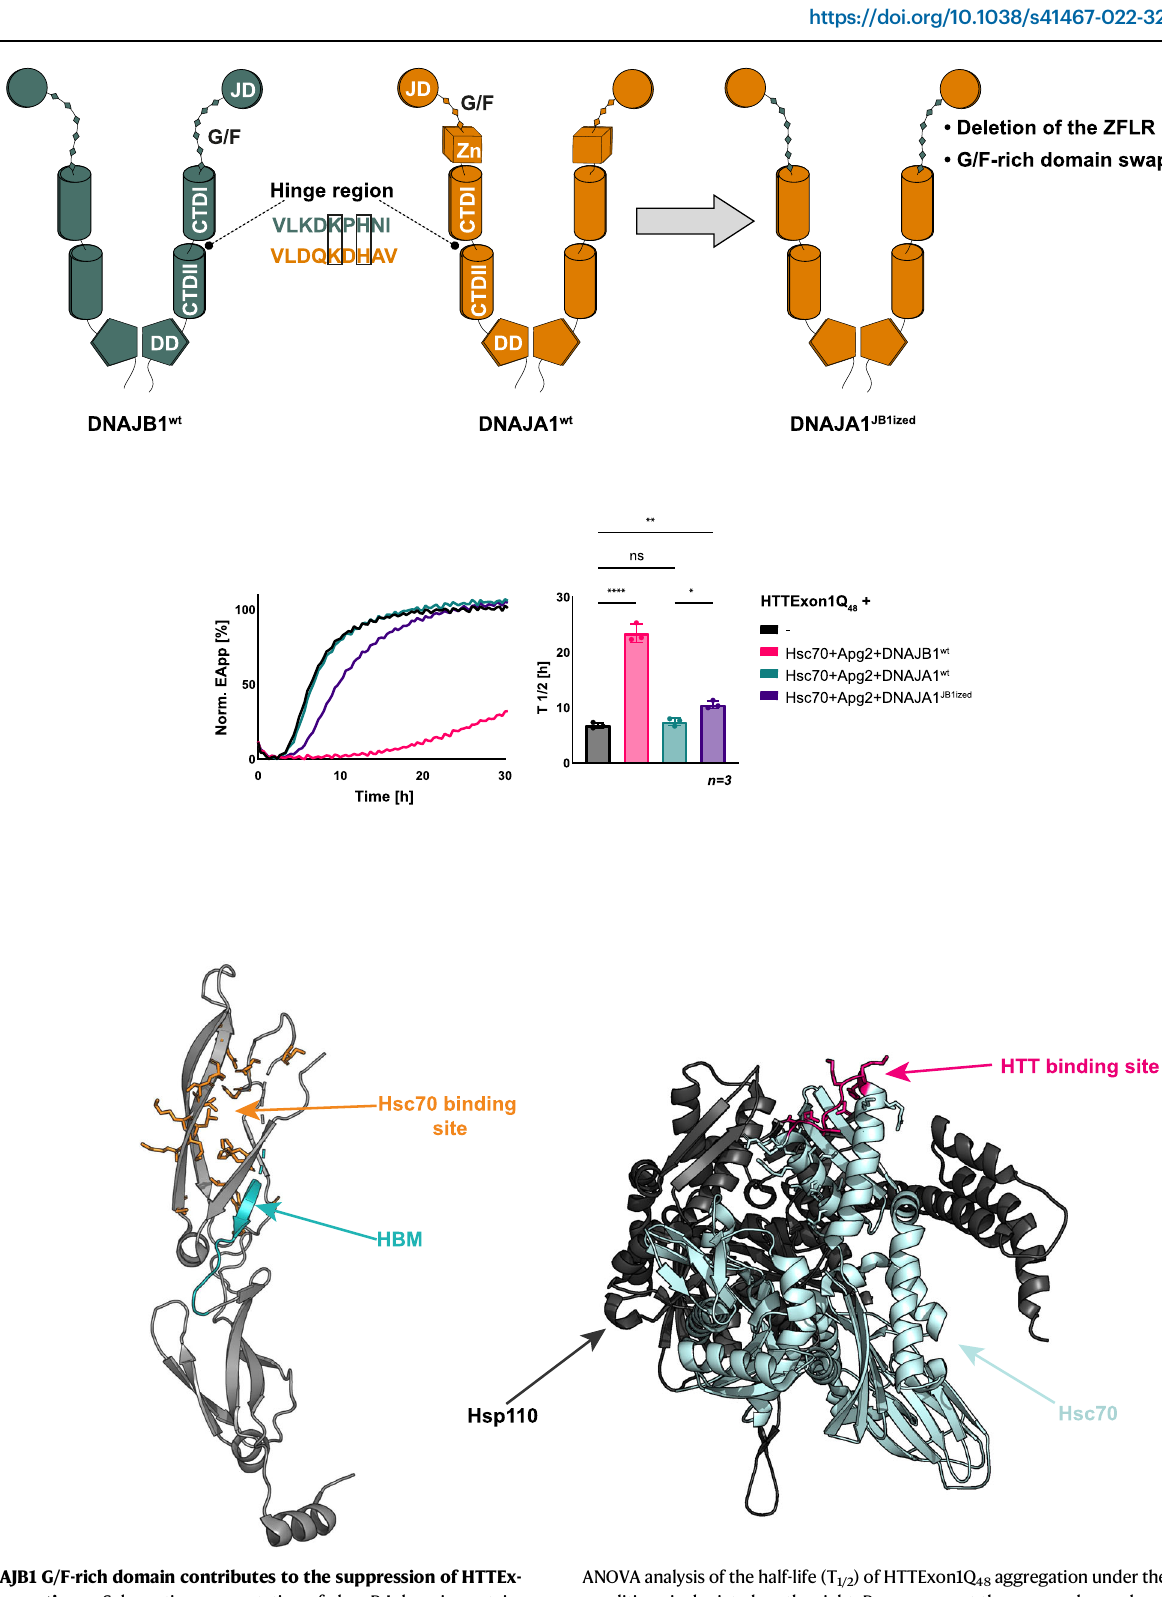
ANOVAanalysisof thehalf-life(T 1/2 )ofHTTExon1Q 48 aggregationunderthetested conditions is depicted on the right. Bars represent the mean value and error bars correspond to the mean SD. **** P ≤ 0.0001; ** P ≤ 0.01; * P ≤ 0.05; ns not signi fi cant. c Left, the crystalstructureof DNAJB1protomer (pdb:3agz) showing inorangethe amino acids identi fi ed as the binding site for Hsc70 23 , and in teal the huntingtin binding motif (HBM) identi fi ed in our study. Right, crystal structure of Hsp110- Hsc70complex(pdb:3c7n).Hsp110isdisplayedindarkgray,andHsc70isshownin light blue.The huntington binding site of Hsc70 identi fi ed byour cross-linking-MS experiments (Fig. 1a) is shown in